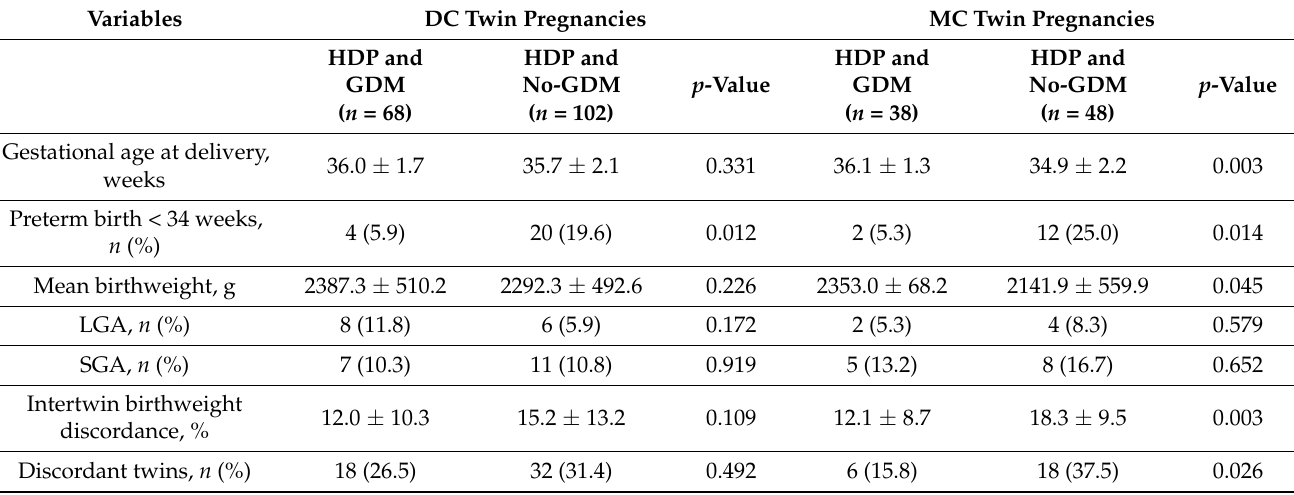
Table 3. Neonatal outcomes among HDP-twin pregnancies complicated by GDM or not, stratified by